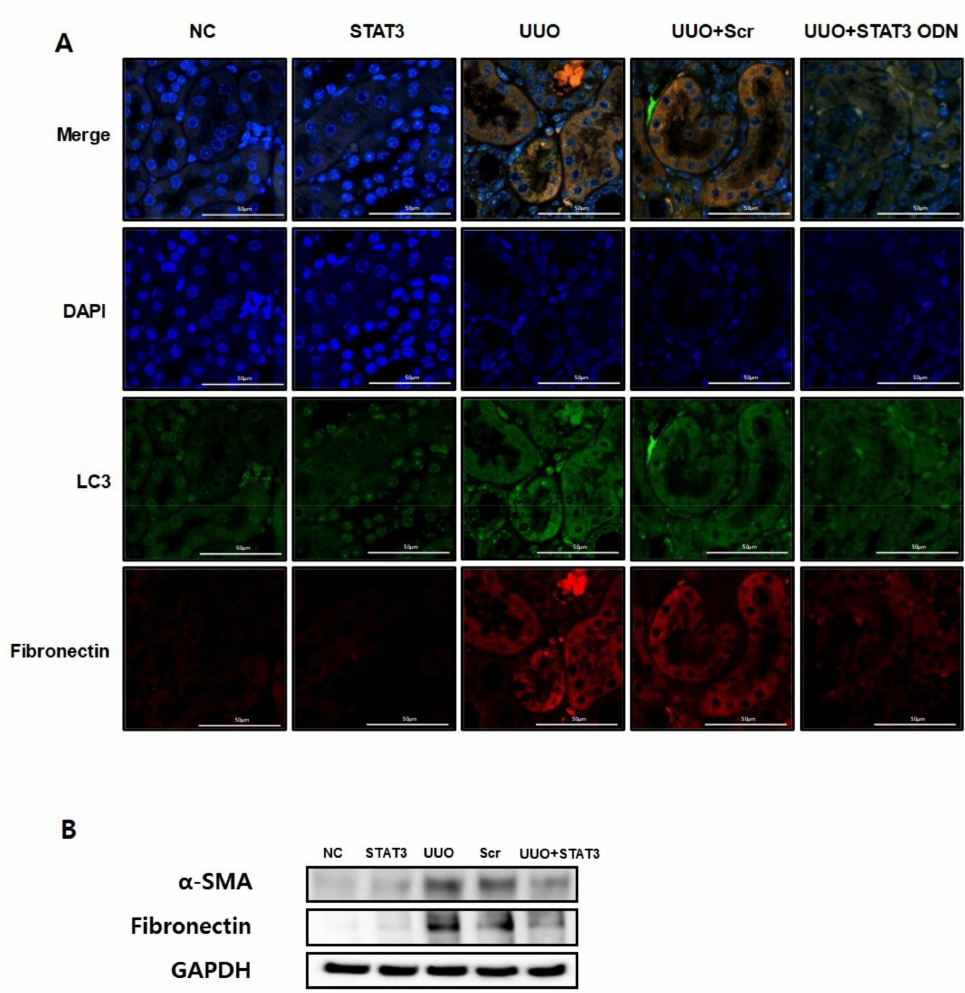
Figure 3. Decrease in Autophagy Expression due to STAT3 Decoy ODNs in UUO-induced Renal Fibrosis. The STAT3 decoy ODN inhibits the expression of fibrotic and autophagy genes in UUO- induced renal fibrosis. ( A ) Immunofluorescence staining shows that LC3 was reduced via STAT3 decoy ODN in UUO-induced renal fibrosis mice. The green color indicates LC3, the red color indicates fibronectin and the blue color indicates the nuclei. ( B ) Western blot analysis shows that STAT3 decoy ODN decreased the expression of fibronectin and α -SMA. Abbreviations: UUO, unilateral ureteral obstruction; decoy ODNs, decoy oligonucleotides; STAT3, signal transducer and activator of transcription 3; α -SMA, α -smooth muscle actin; LC3, microtubule-associated protein light chain 3; DAPI, 4 (cid:48) ,6-diamidino-2-phenylindole, Scr,